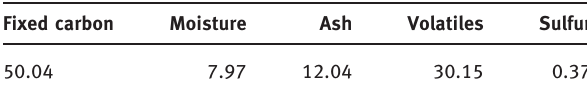
Figure 1: The relationship of standard free energy with temperature for eqs (1) –